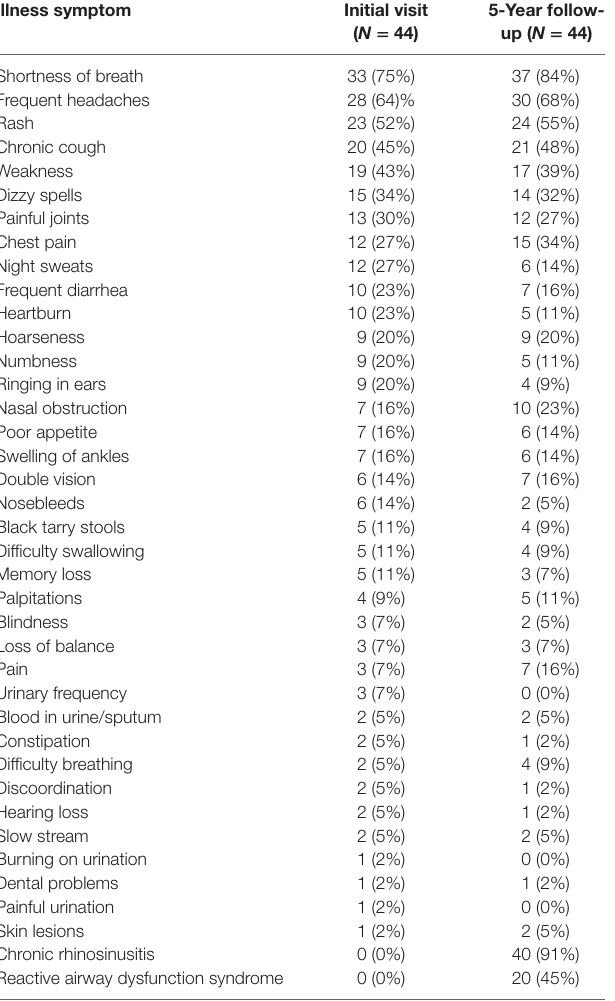
TaBle 2 | Incidence of somatic symptoms complaint by the oil spill cleanup works during initial visits and 5 years after the Gulf oil spill exposure.